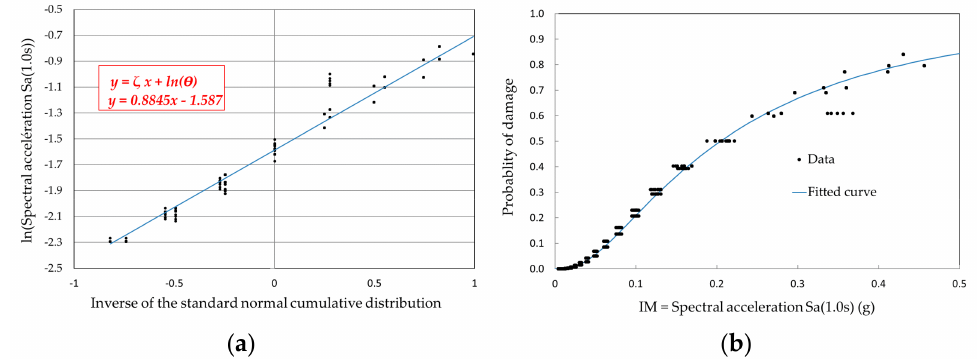
Figure 2. Fitting procedure for implicit fragility function for light wood frame building classes W1-l and W1-m experiencing slight damage for the magnitude M6: ( a ) Linear approximation; ( b ) Curve